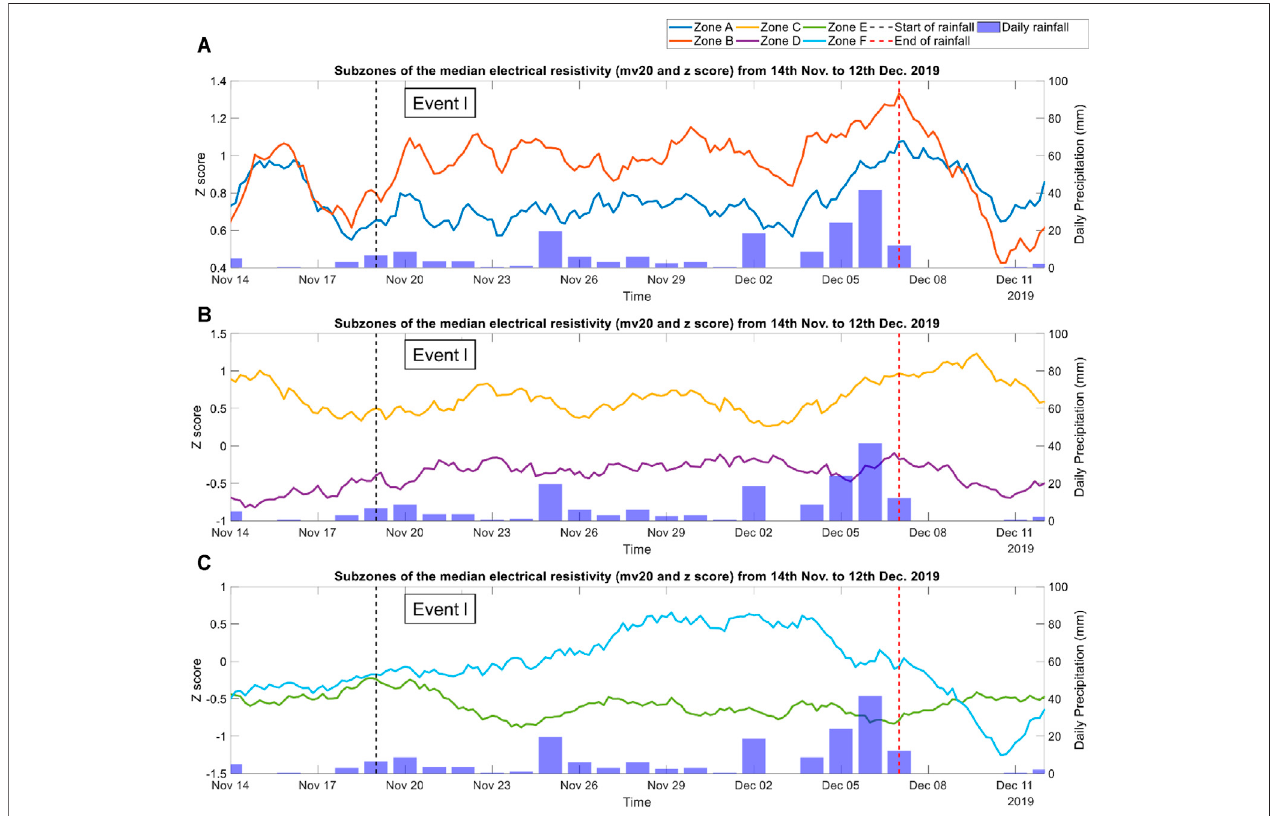
FIGURE8| Standardscore,i.e.,Z-score,instatisticsofthemedianelectricalresistivity(MEER)timeseriesforthelong-durationprecipitationevent(Eventl).Moving average for 20 measurements (mv20) of the MEER curves: (A) Zones A and B, (B) Zones C and D, and (C) Zones E and F.